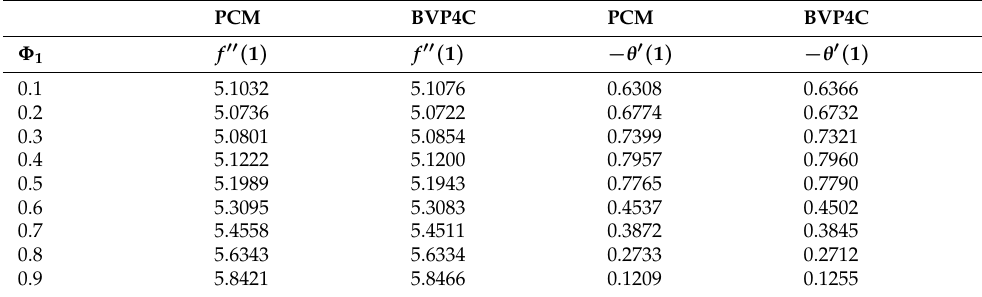
Table 4. Comparison of the numerical results by two methods PCM and BVP4C for skin friction and Nusselt number, with various physical parameters and Φ 2 =